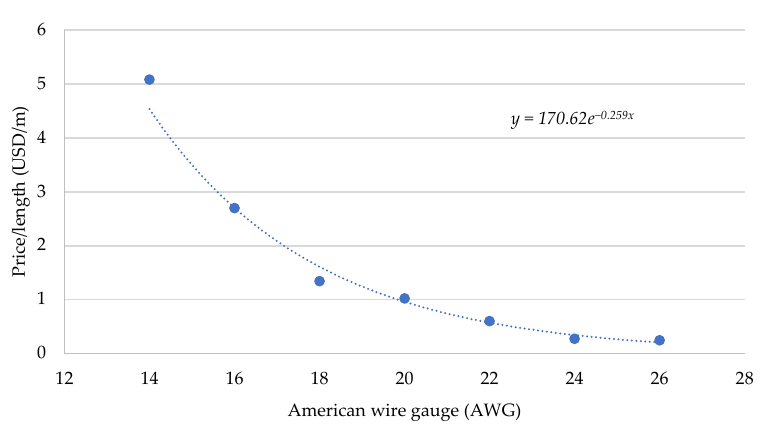
Figure 12. Price of Litz wire according to the AWG.